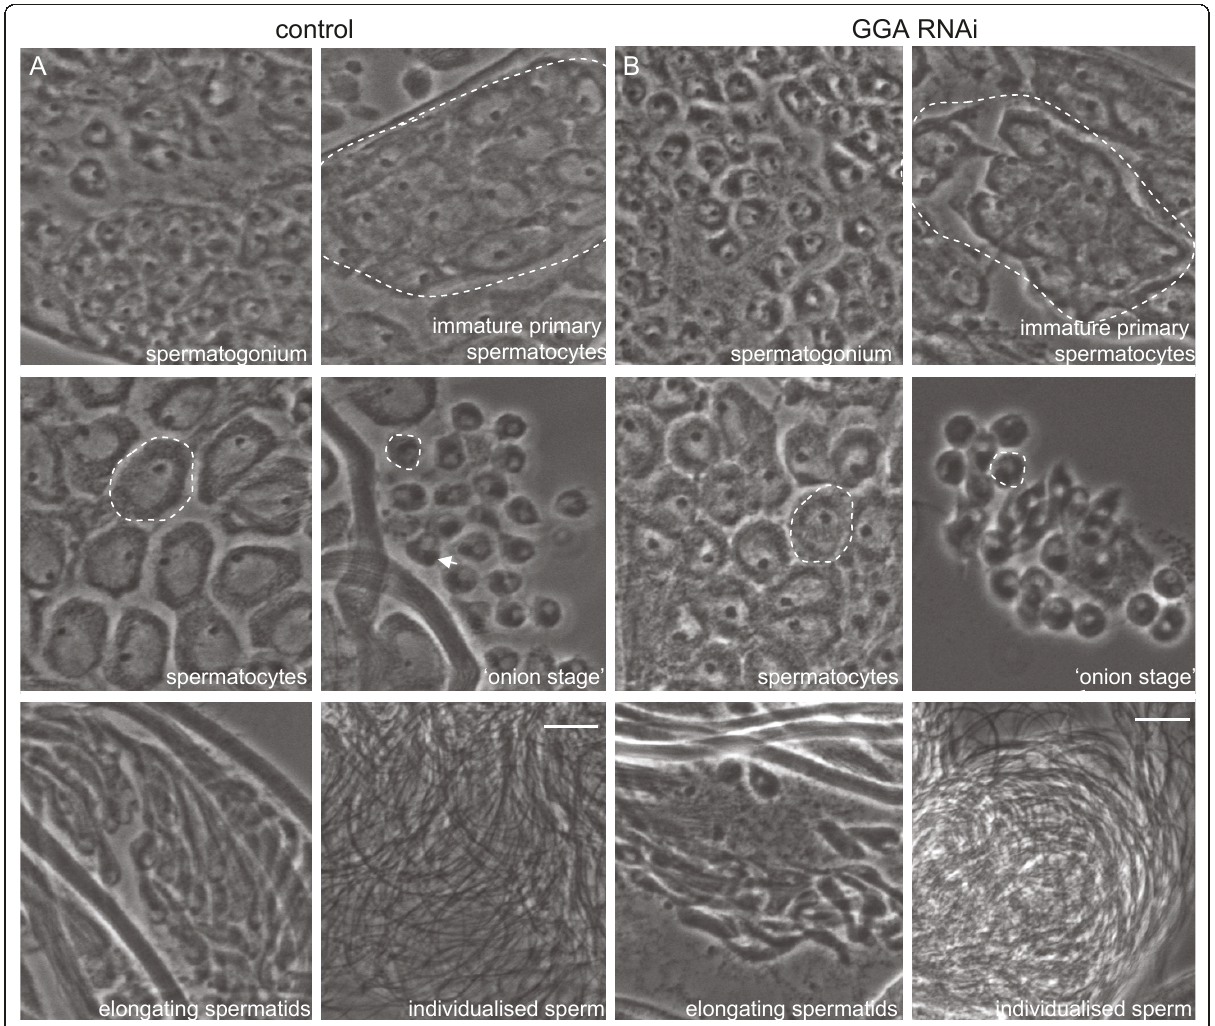
Figure 7 Visualisation of all stages of spermatogenesis in GGA knockdown testes . GGA was depleted ubiquitously using a Tubulin-Gal4 driver and testes squashes from male flies were compared with those from control flies. By phase contrast microscopy we observed no differences in the morphology of the stages of spermatogenesis in the GGA depleted testes. Note that all stages in spermatogenesis were visualised, culminating in individualised sperm. Bar, 20 μ m.